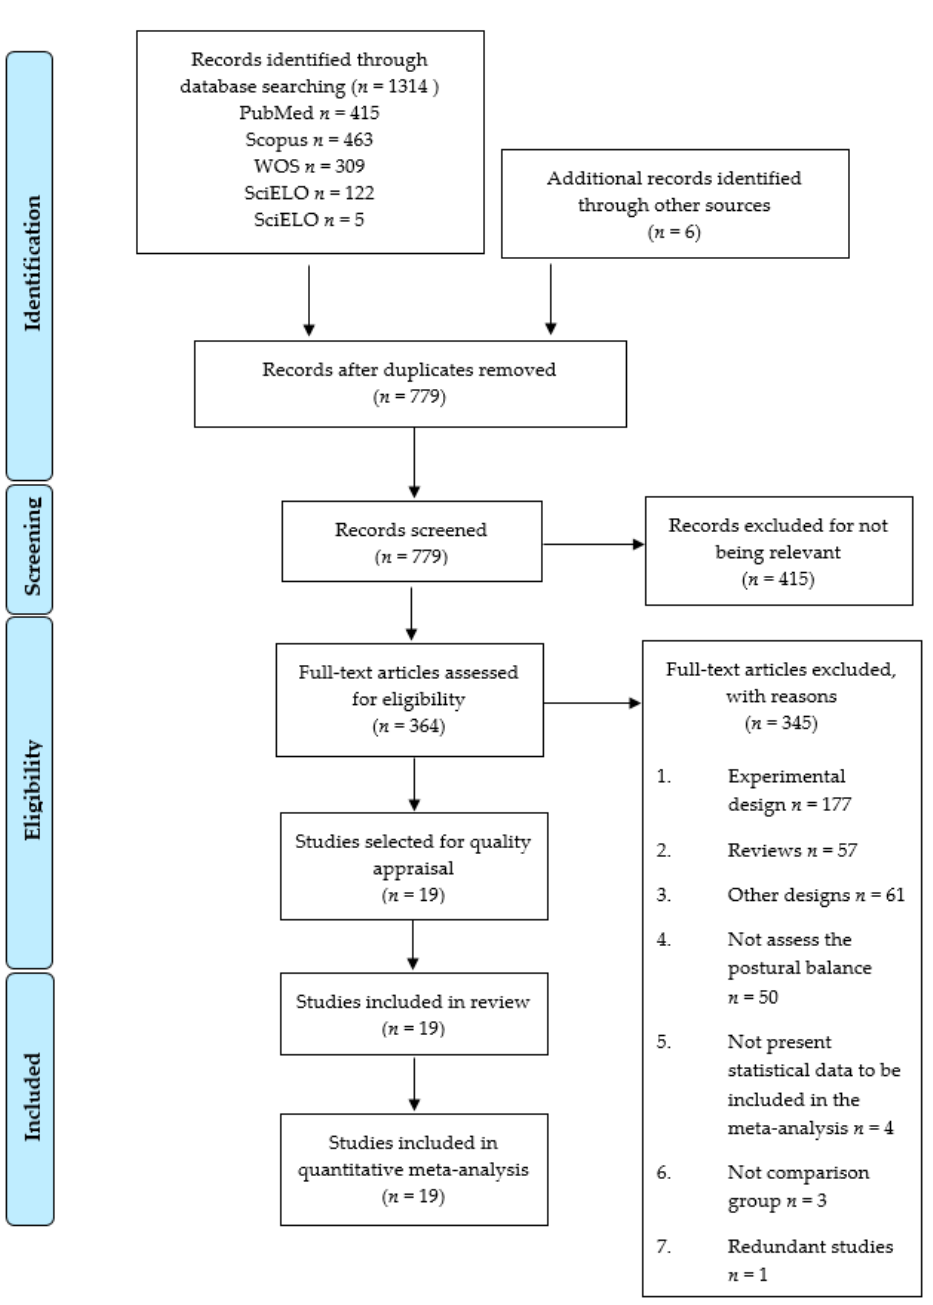
Figure 1. Preferred Reporting Items for Systematic Reviews and Meta-Analysis (PRISMA) flow chart .